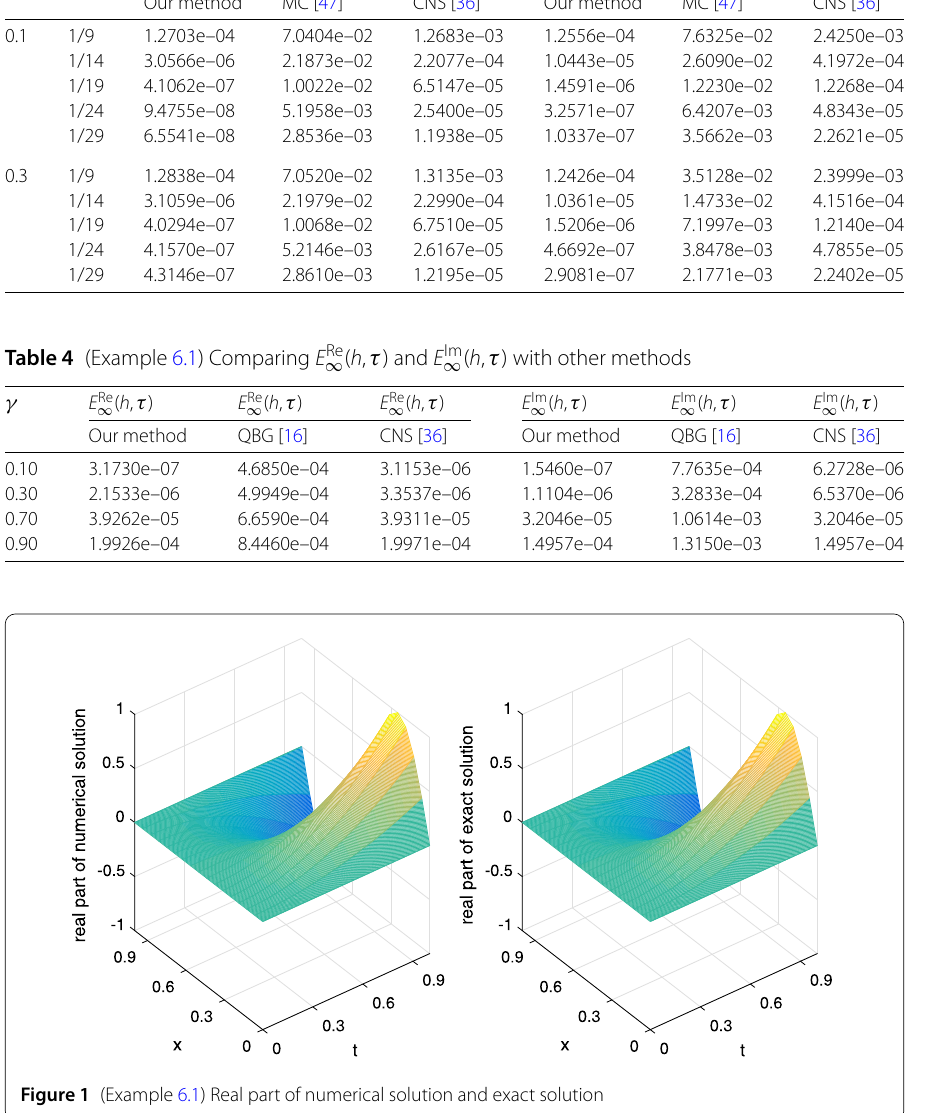
Figure 1 (Example 6.1) Real part of numerical solution and exact